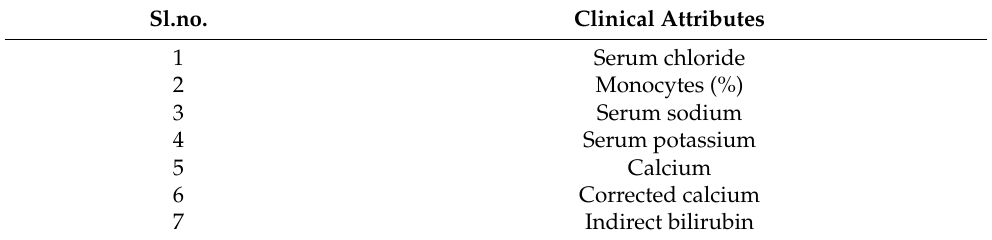
Table 2. List of informative attributes from the COVID-19 clinical dataset using the mRMR algorithm.